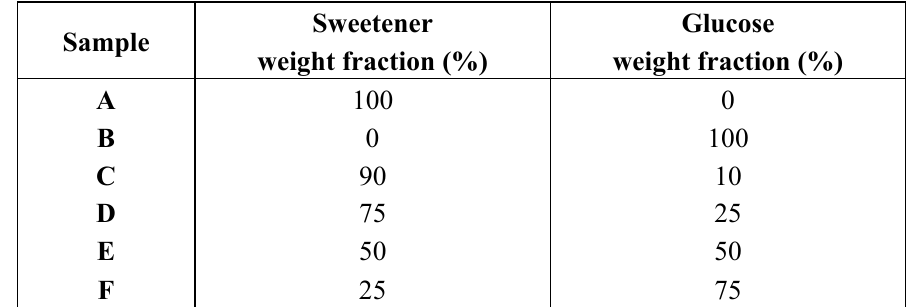
Table 1 . Composition of mixed solutions. Details on the used commercial sweetener available on